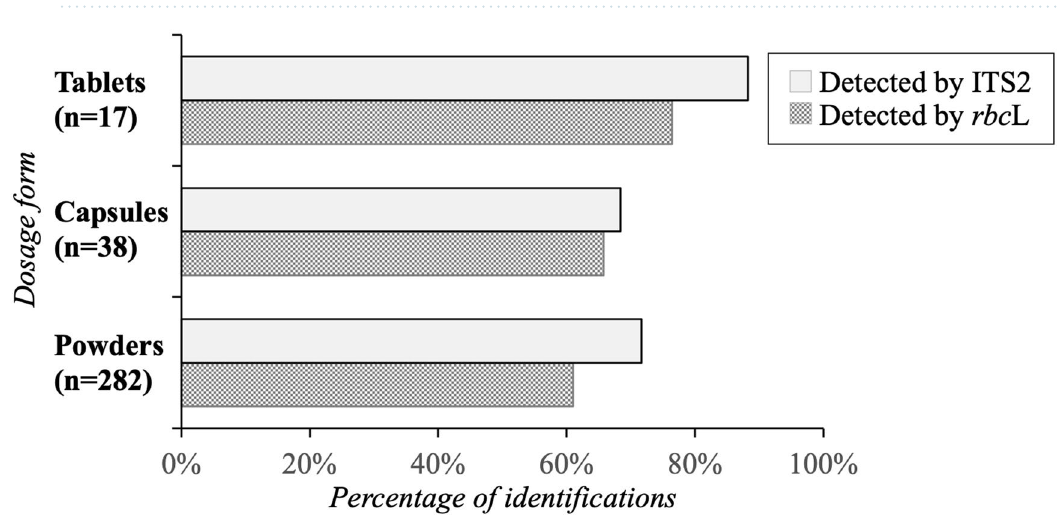
Figure 2. Identification of herbal products based on dosage form; ‘n’ represents the total number of plant families claimed on products’